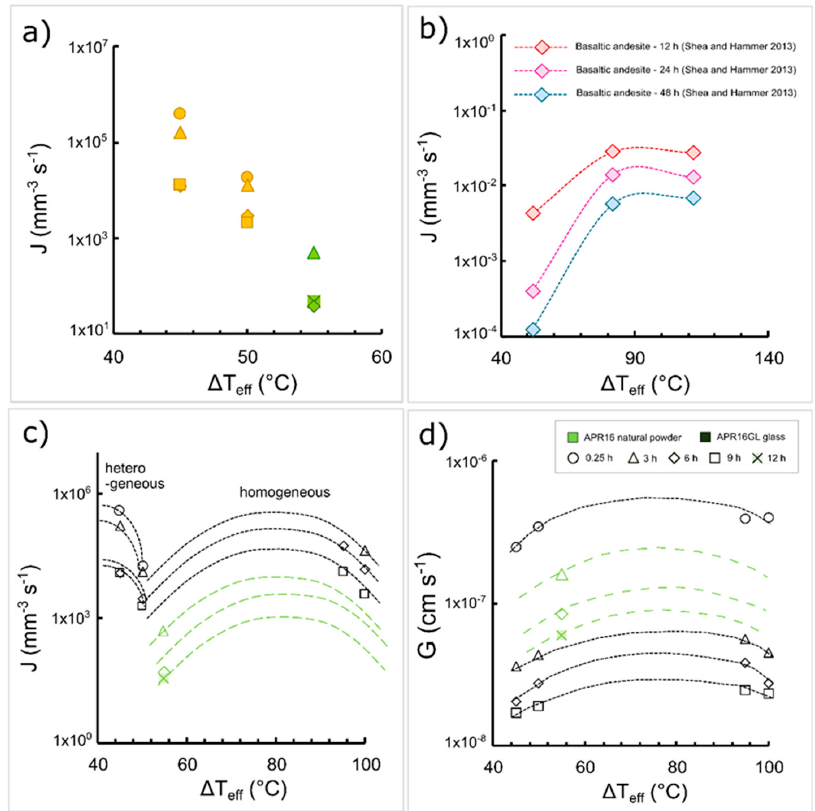
Figure 6. Relation between the nucleation rate ( J ) and the experimental time. Symbols are as in Figure 2. Black asterisks indicate the single step cooling runs ( Δ T eff = 52–82 °C) of Shea and Hammer [17].